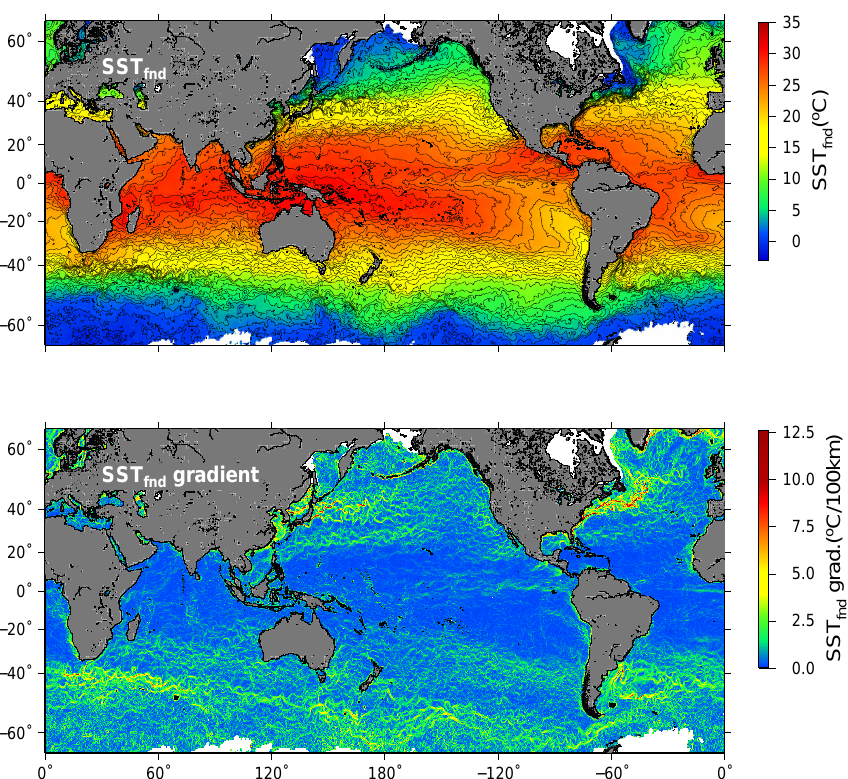
Figure 1. Example of the satellite-based foundation sea surface temperature (SST) (SST fnd : top) and (cid:113) ( ∂ x SST ) 2 + ( ∂ y SST ) 2 ) on 1 January 2014 of this work. The contour interval spatial gradient ( fnd fnd (C.I.) in the SST fnd field is 1 ◦